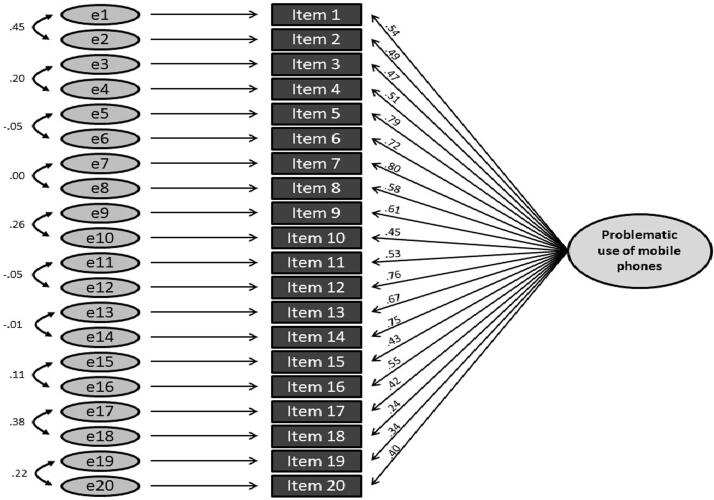
Path diagram for the confirmatory factor analysis of the PUMP-D for Model 2 with intercorrelated items for each addiction criterion, showing standardised path coefficients. All path coefficients are significant at p < .001.